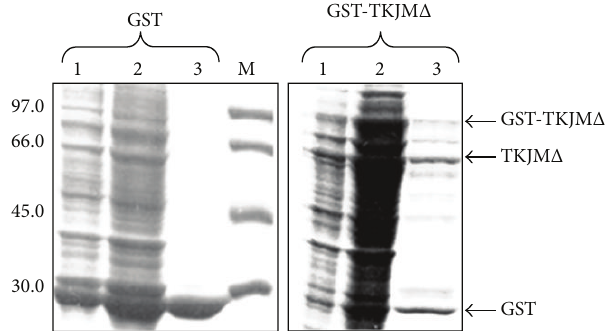
Figure 3: Recombinant protein purification. The recombinant GST- TKJM Δ and GST proteins were purified as described in Section 2. Lane 1: flow through; lane 2: ATP-wash; and lane 3: eluted pro- teins. The samples were run in 10% SDS/PAGE and stained with Coomassie blue. The arrow points to the TKJM Δ recombinant